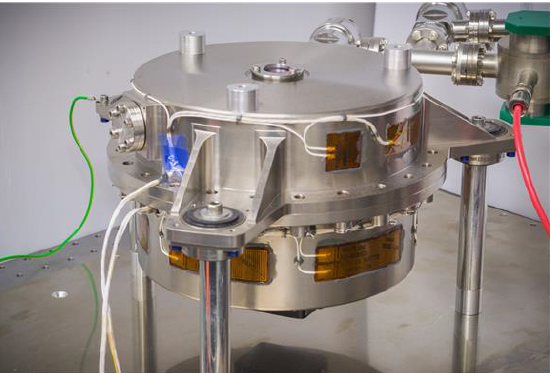
Figure 7. Photo of the thermally controlled vacuum system containing the cavity (image credit: Airbus DS).